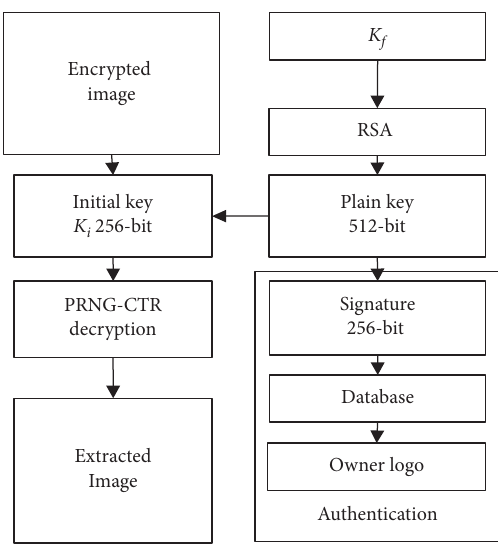
Figure 3: General architecture of the extraction